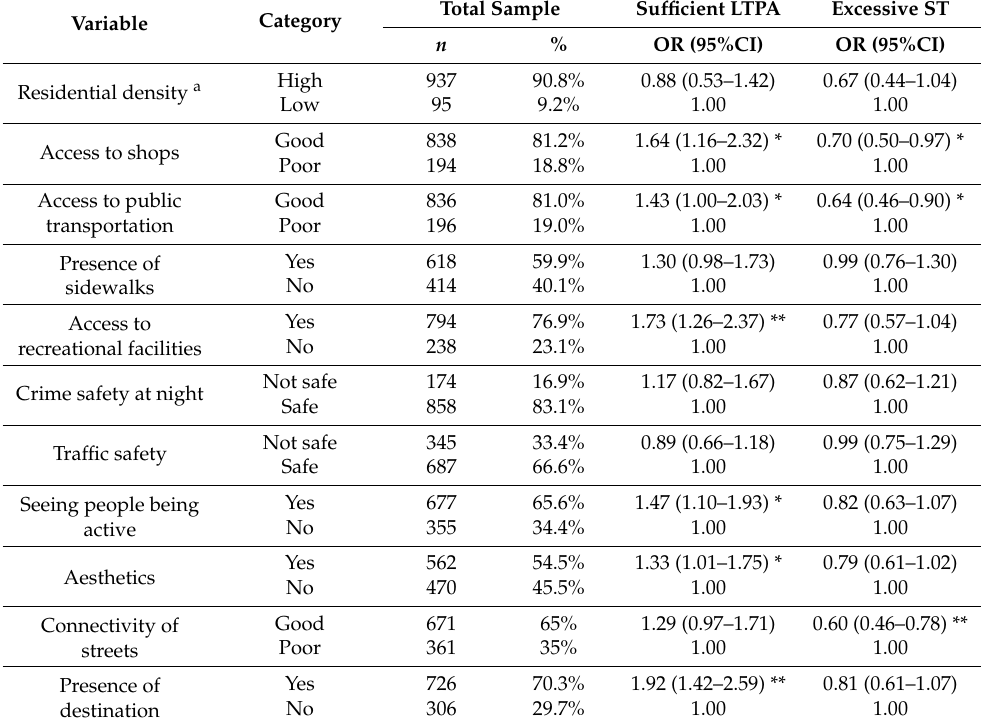
Table 2. Perceived Environmental Factors Associated with LTPA and